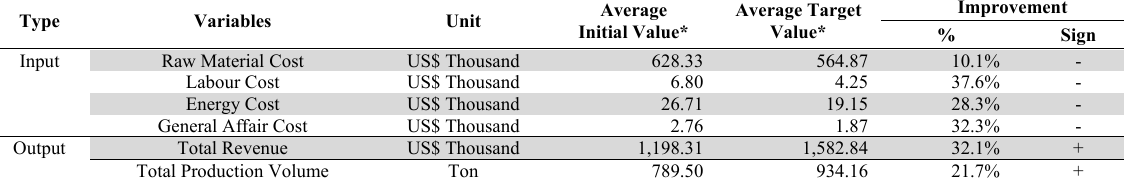
General Improvement Target of Each Operational Variable (Input & Output)